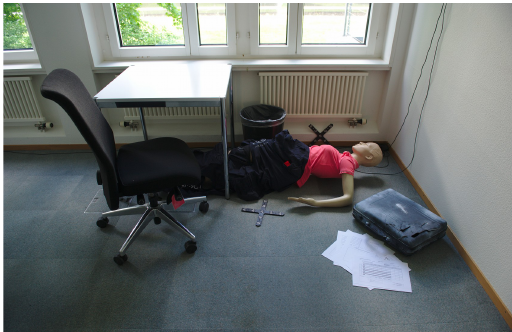
Figure 3. Scene overview before alteration (placing a forensic scale) of the